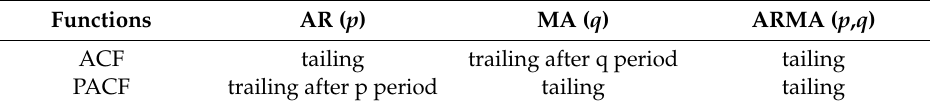
Table 4. Summary of ARMA model recognition graph judgment